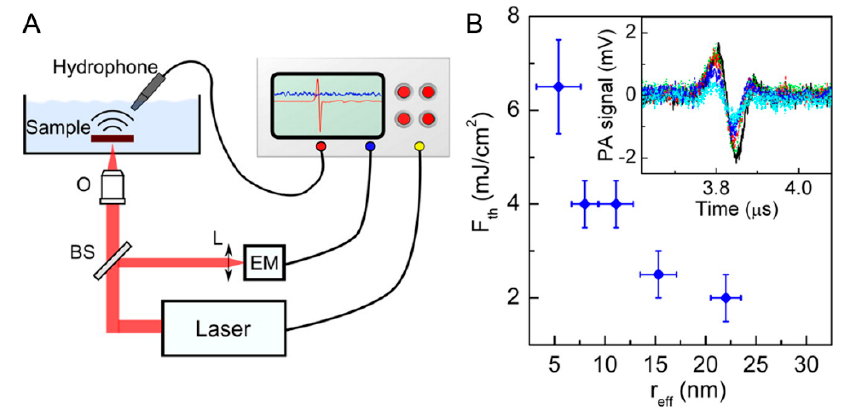
Figure 5. ( A ) Sketch of the setup used for the photoacoustic experiments (O, objective; L, focusing lens; BS, beam splitter; EM, energy meter); ( B ) trend of F th as a function of effective nanoparticle radius (r eff ). In the inset: comparison of PA response with a single pulse excitation at fluence F < F th for samples containing gold nanorod (GNR)5 (black line), GNR8 (green line), GNR11 (red line), GNR15 (dark blue line), and GNR22 (light blue line). GNR5, GNR8, GNR11, GNR15, and GNR22, with the numbers denoting their average effective radii (radius of a sphere having the same volume as the rod) in nanometers [71].